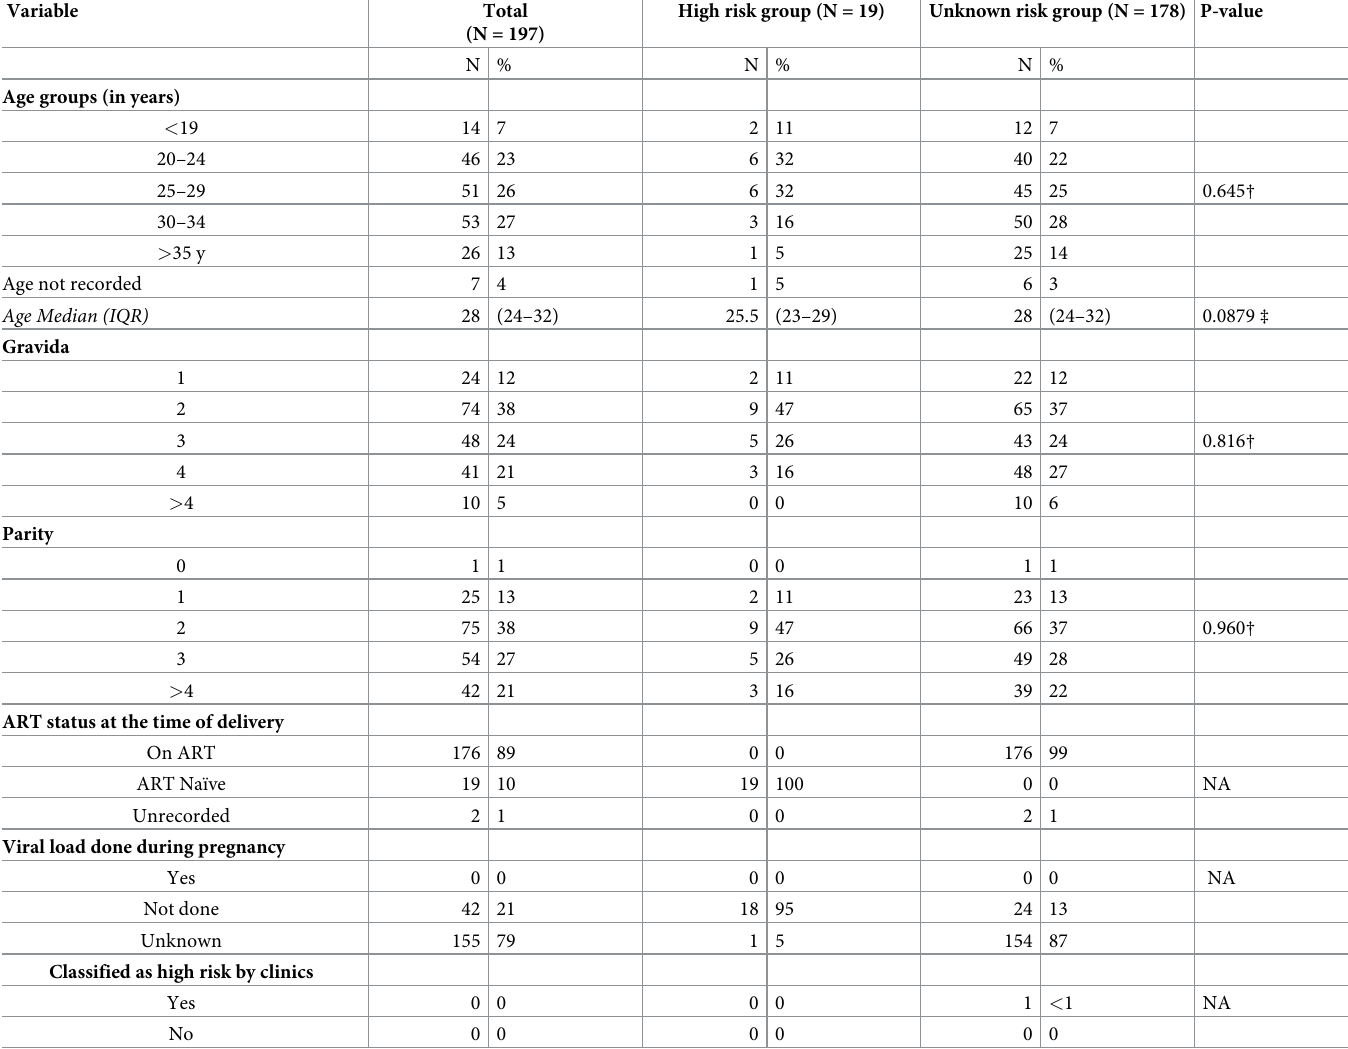
Table 1. Characteristics of HIV-positive pregnant women who delivered in 12 Clinics owned by Harare City Health Department in August 2017 stratified by their risk of maternal to child transmission of HIV infection.